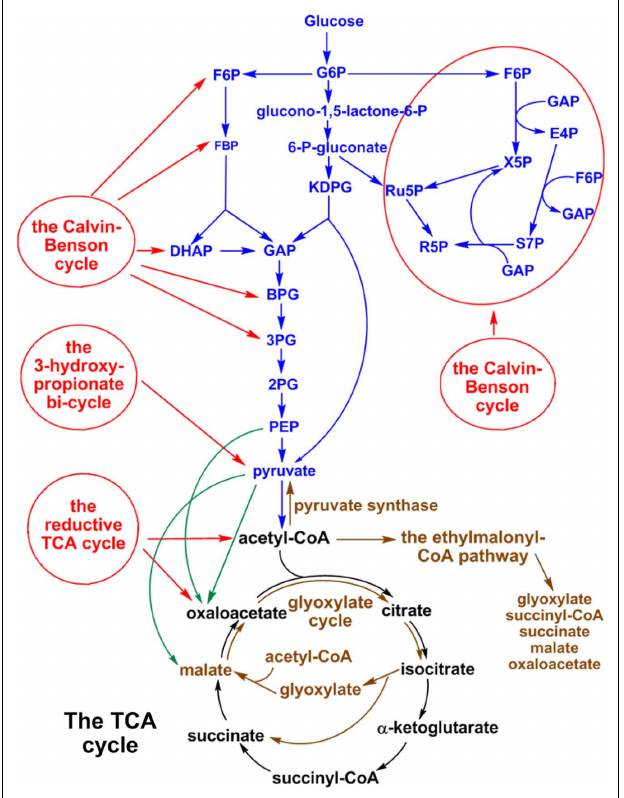
FIGURE 1 | Schematic representation of central carbon metabolism in phototrophic bacteria. The metabolic pathways of autotrophic CO 2 fixation (red lines), anaplerotic CO 2 assimilation (green lines), carbohydrate metabolism (blue lines), acetate assimilation (brown lines), and theTCA cycle (black lines) in phototrophic bacteria are shown. Some metabolic pathways are employed only in phototrophic bacteria, and others are distributed in phototrophic and non-phototrophic